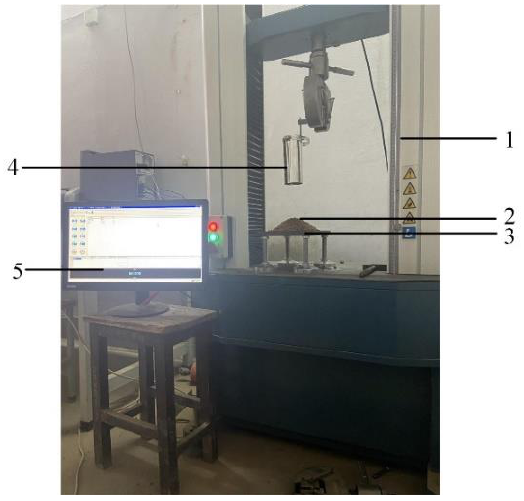
Figure 3. Physical test of stacking angle. (1) Universal tensile testing machine; (2) soil sample; (3) steel plate; (4) steel cylinder; (5) computer.